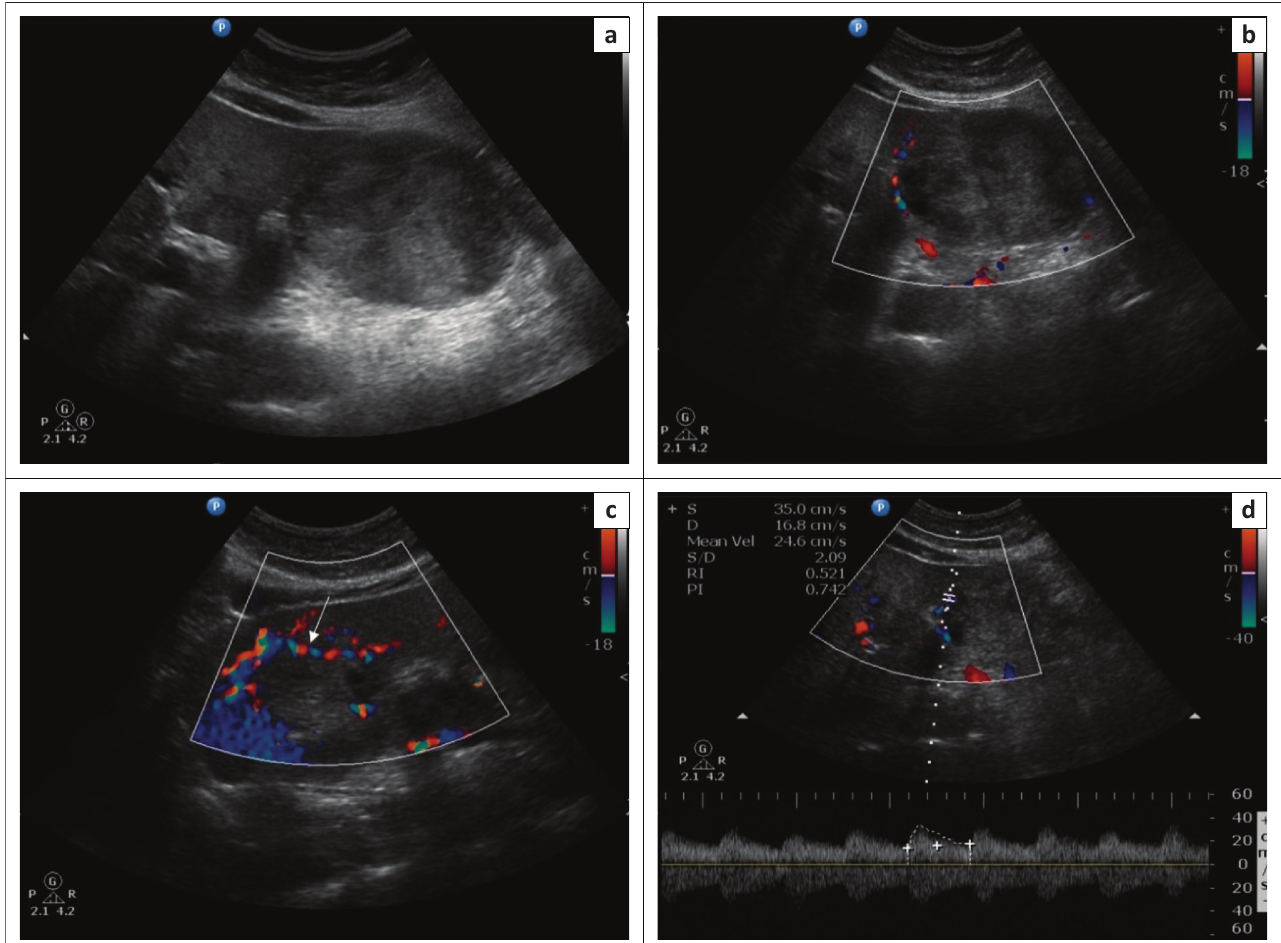
FIGURE 5: Grayscale ultrasound (a) shows the mass lesion scalloping the left lobe of the liver. Doppler examination (b) shows increased vascularity in the left lobe of the liver adjacent to the lesion with a tortuous bridging vessel (c) passing through a sliver of tissue from the left lobe to the mass (arrow). Doppler waveform (d) from the bridging vessel shows arterial flow.